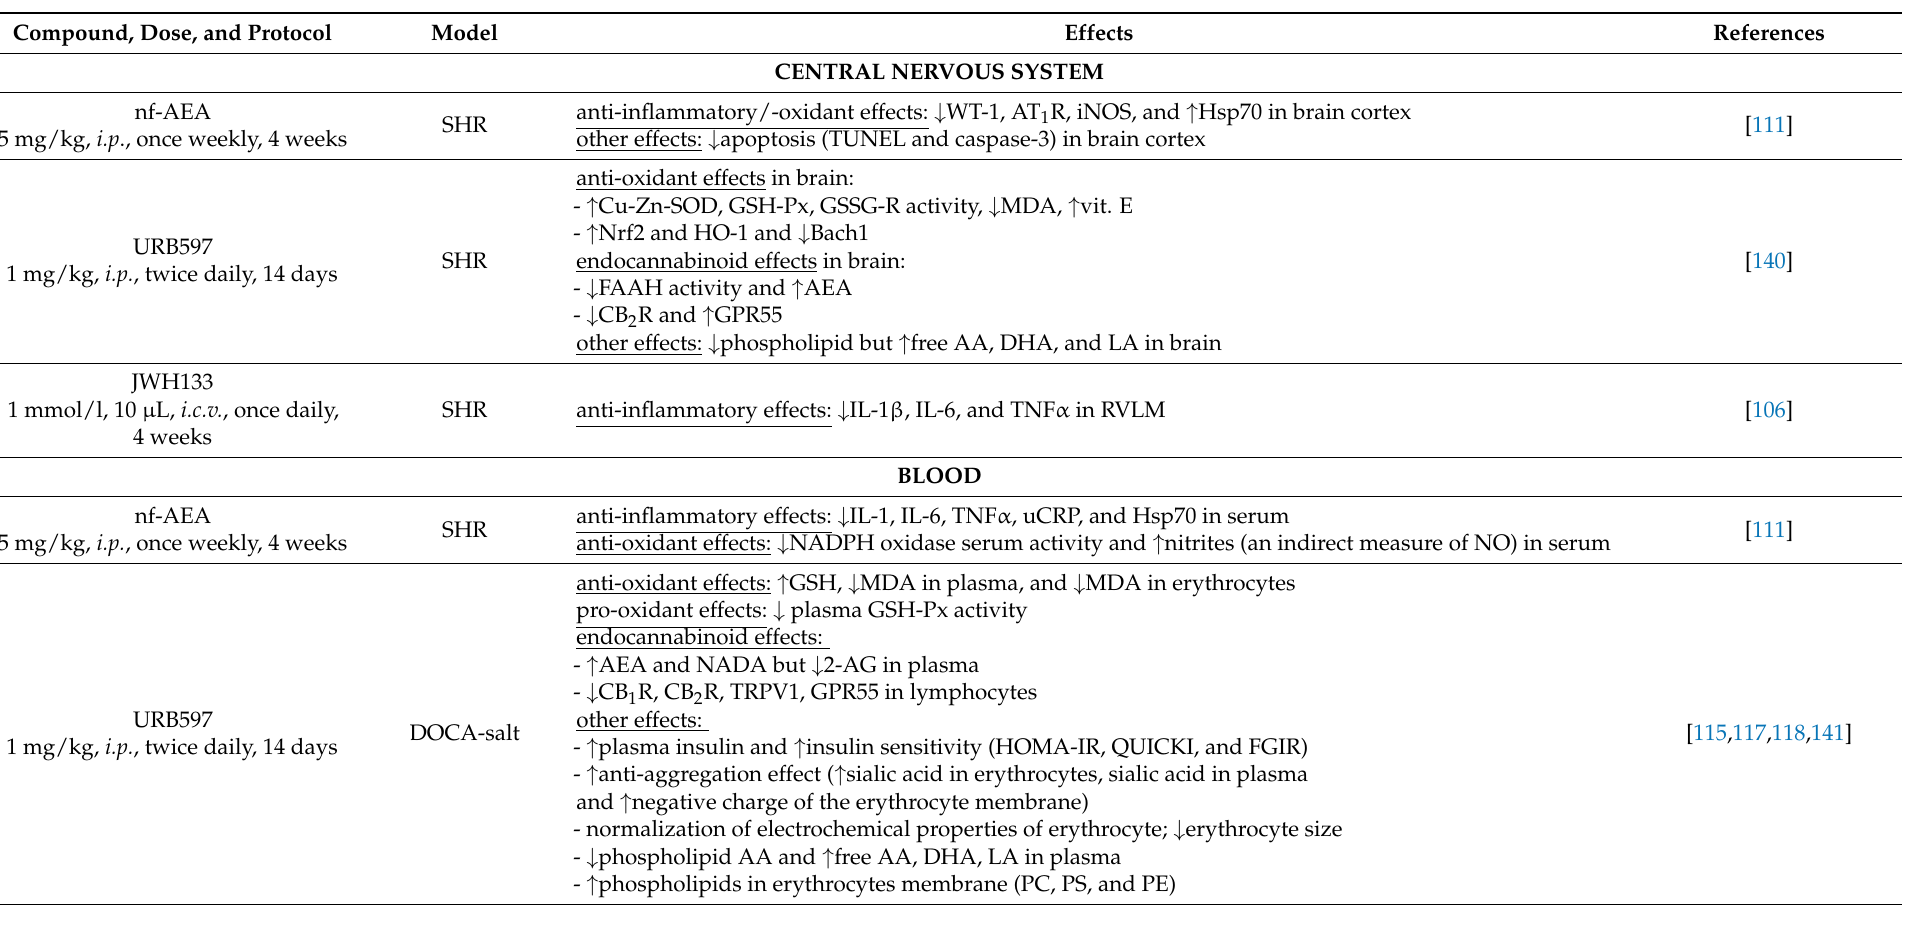
Table 4. Effects of chronic administration of (endo)cannabinoids in various tissues of different models of systemic hypertension in male rats (unless noted otherwise). Compound, Dose, and